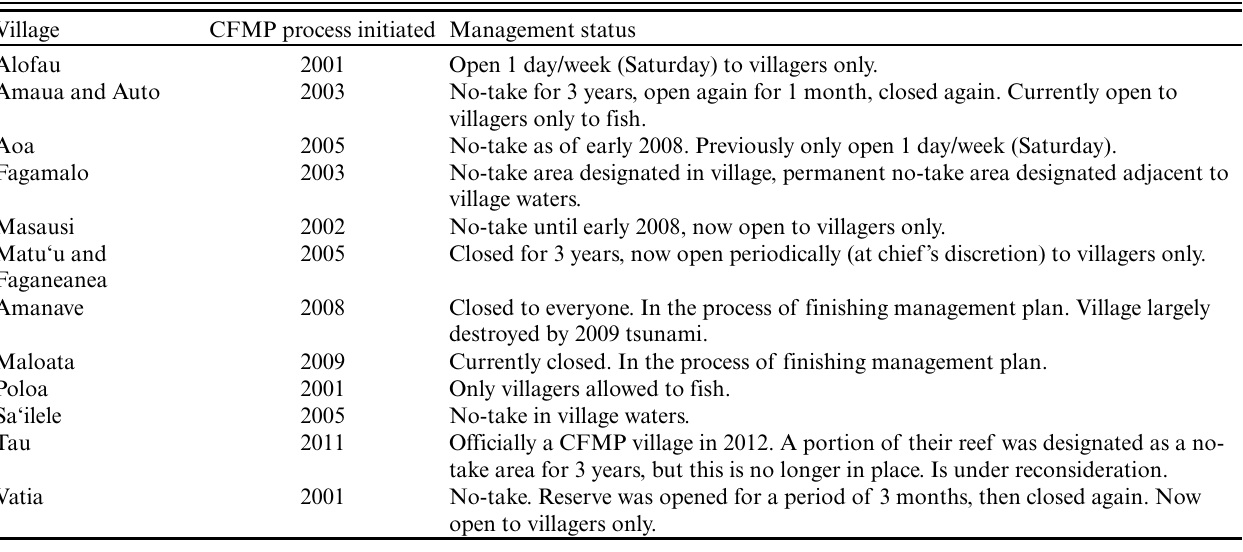
Table 2 . Villages involved in American Samoa’s Community-Based Fisheries Management Program (CFMP).